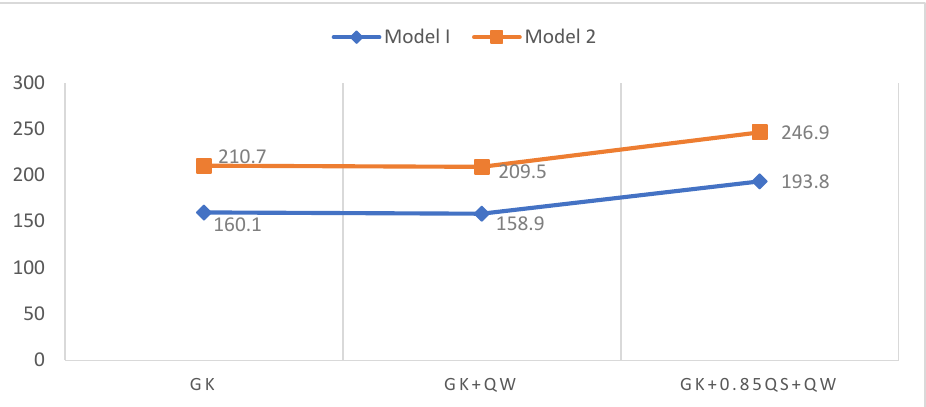
Figure 31. Nonlinear displacement polygraph of two carports under conventional load. The data in the figure are derived from the simulation results of the finite element software.